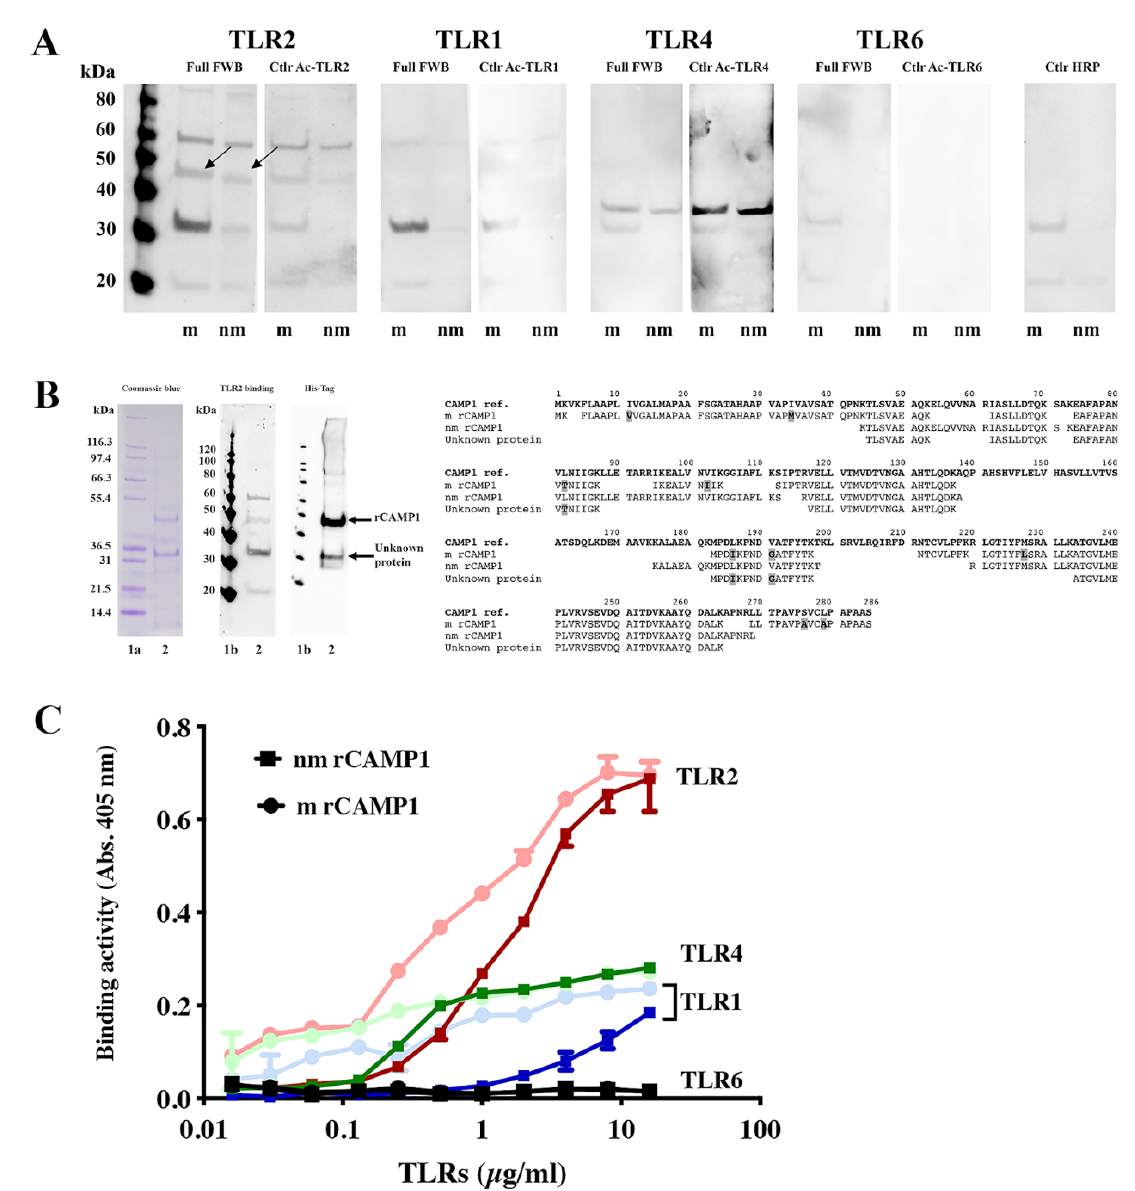
Figure 3. Specific recognition of C. acnes recombinant CAMP1 by TLR-2. ( A ) The recombinant proteins nmrCAMP1 (nm) and mrCAMP1 (m) (50 µ g) were separated by electrophoresis in a 4–12% NuPAGE SDS BisTris gel and transferred onto nitrocellulose membranes, which were incubated with recombinant TLR-2, TLR-1, TLR-4 and TLR-6 (0.1 μg/mL). TLR binding activity was detected with specific biotinylated antibodies against TLR-2, TLR-1, TLR-4 and TLR-6, respectively, as described in the Materials and Methods. The arrow indicates the position of the 47 kDa band of interest. ( B ) The recombinant proteins were separated by electrophoresis in a 4–12% NuPAGE SDS Bis- Tris gel (50 μg) with detection by Coomassie brilliant blue staining. The separated proteins were